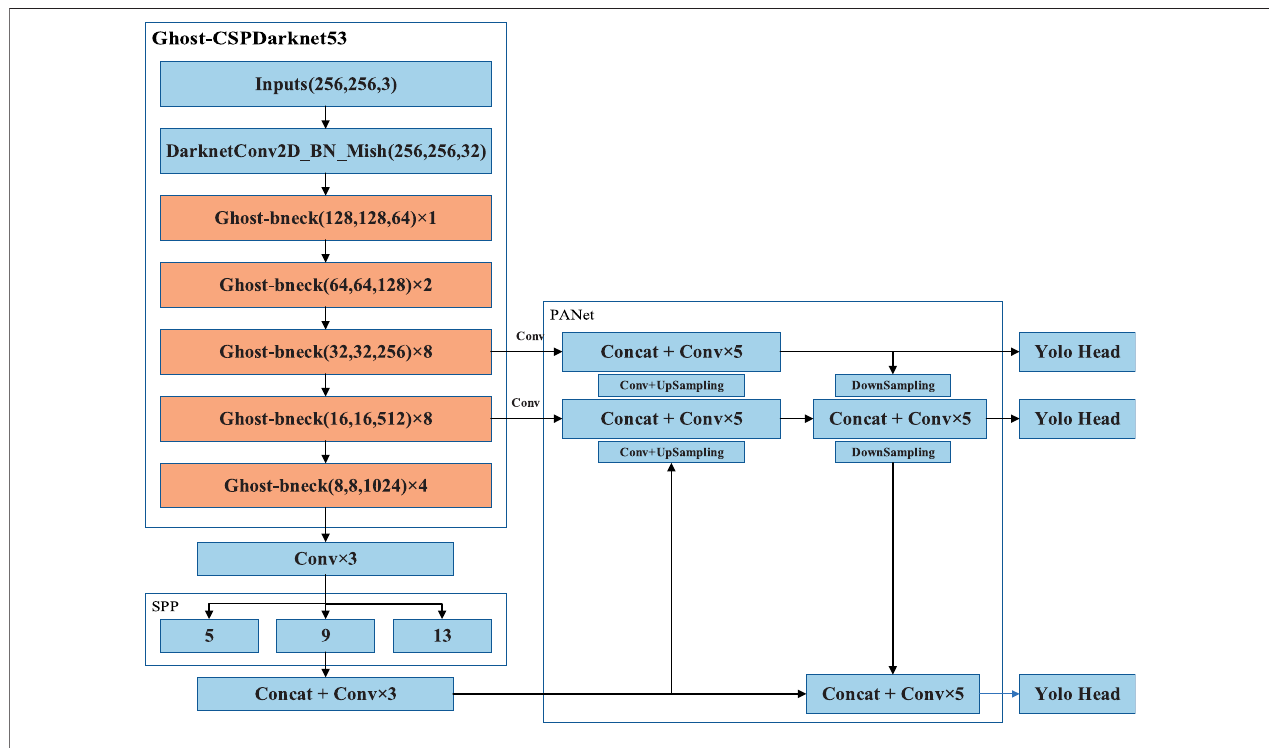
FIGURE 5 | The lightweight YOLOv4 model